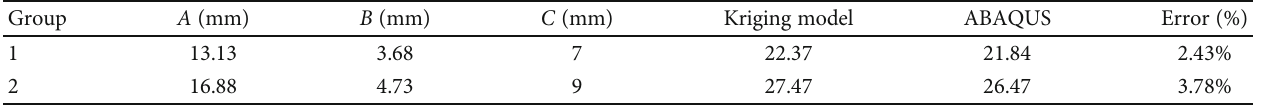
Table 5: Kriging model